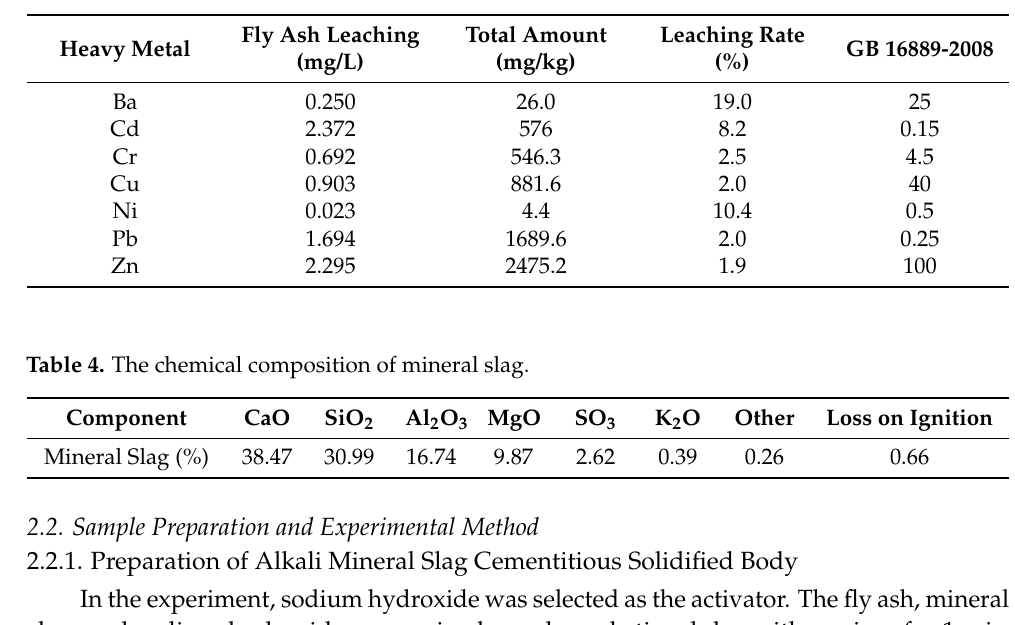
Table 3. Total amount and leaching concentration of heavy metals in fly ash.